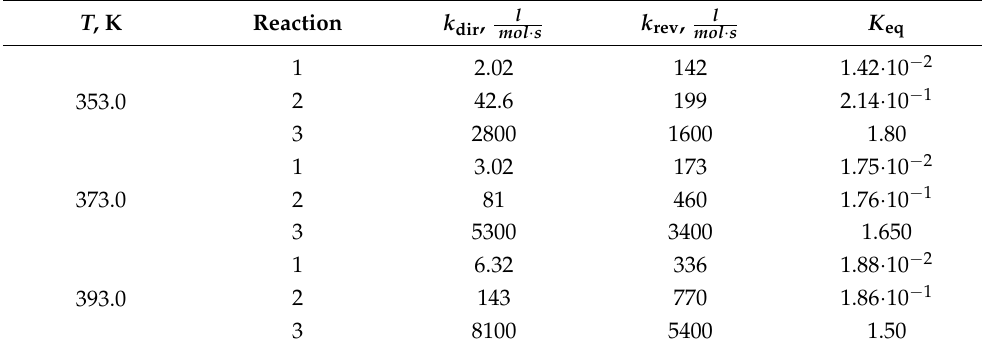
Table 3. The rate constants of direct and reverse reactions and the equilibrium constants of the system of equations (1)–(3) obtained by optimizing the parameters of the kinetic model (6). T , K